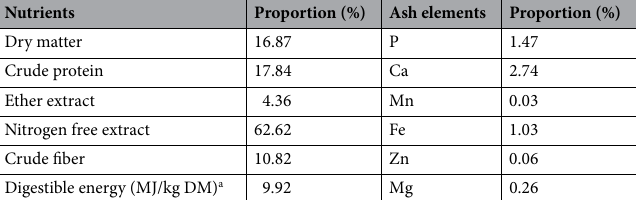
Table 3. Chemical analysis of hydroponic barley. a DE estimated according to Fekete 19 .